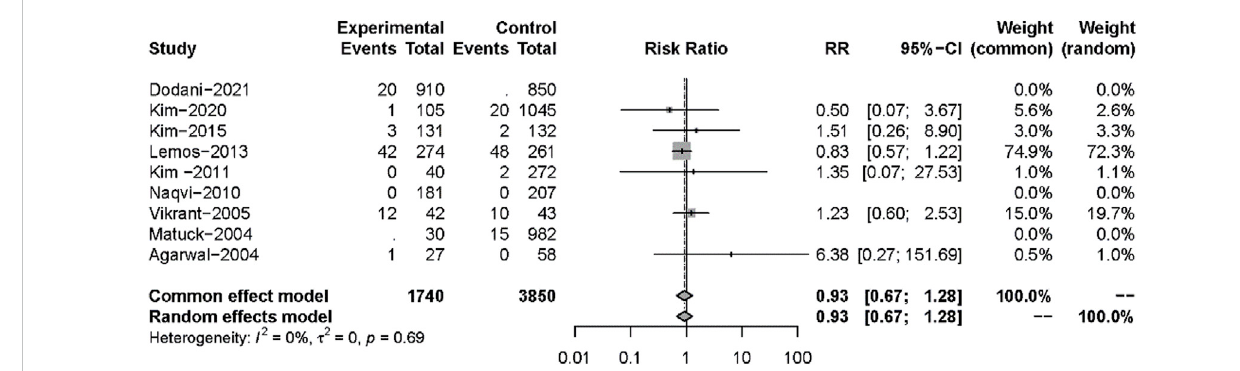
FIGURE 4 Forest plot for outcomes of all-cause mortality comparing isoniazid versus no treatment.